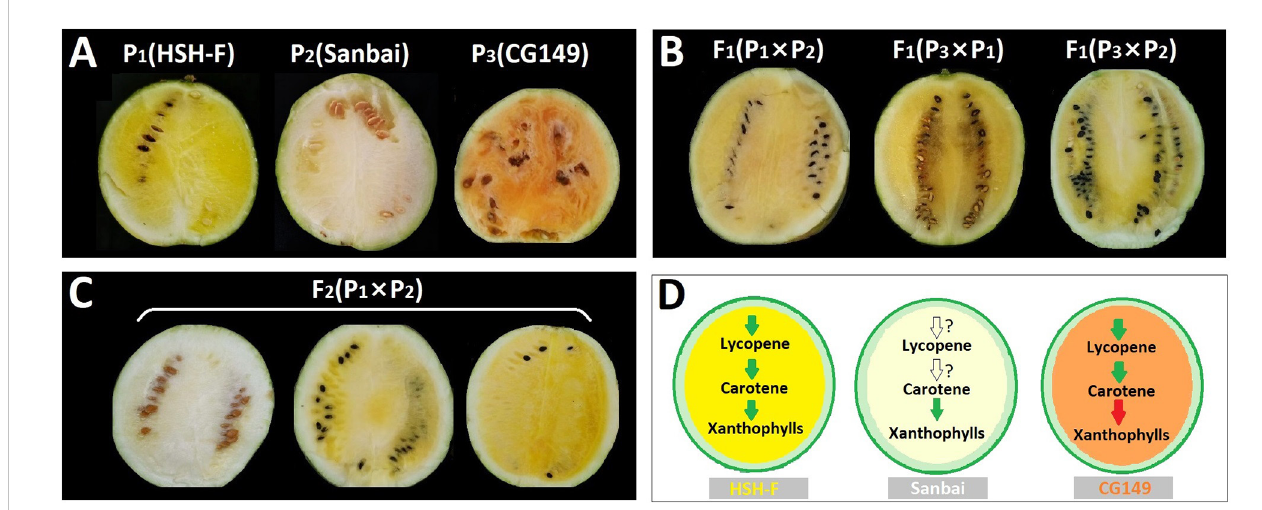
TABLE 1 Segregation ratio of the fl esh color in the F 2 , F 3 , and BC 1 populations derived from crossing the white fl esh with the canary yellow fl esh inbred line (HSH-F × Sanbai). Generation Total Yellow White